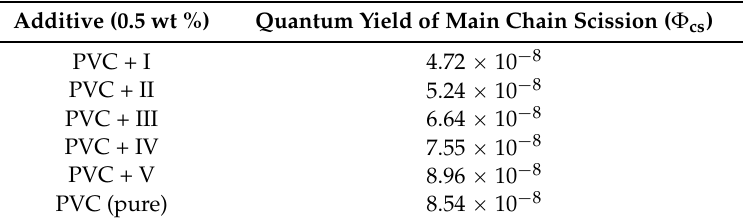
Table 1. Quantum yield ( Φ cs ) for the chain scission for PVC film (30 μ m) thickness with and without 0.5% (wt/wt) additive after a 250-h irradiation time.